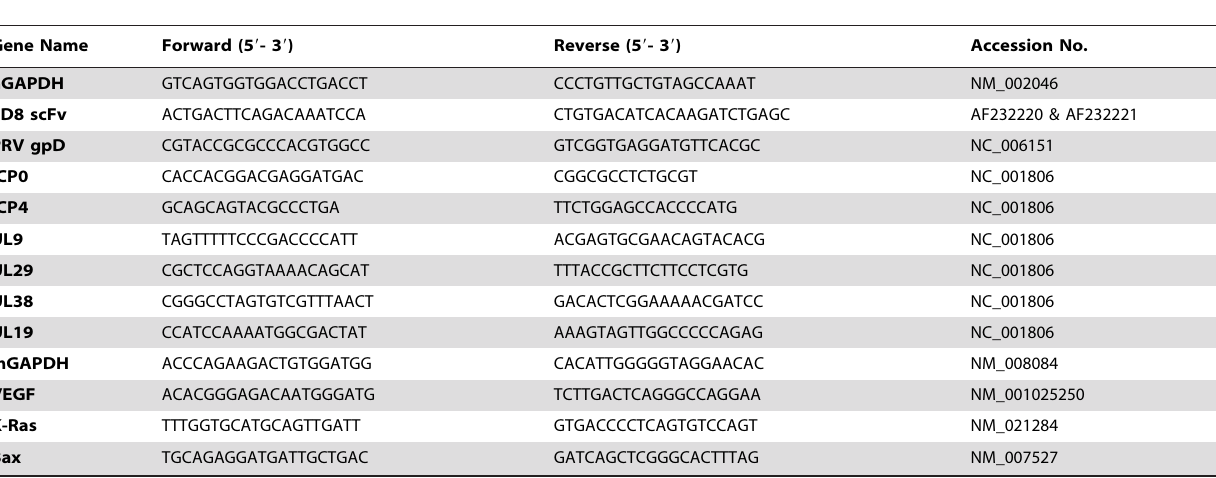
Table 2. Polymerase chain reaction (PCR) primers for the detection of viral genes and global genes analyzed in this